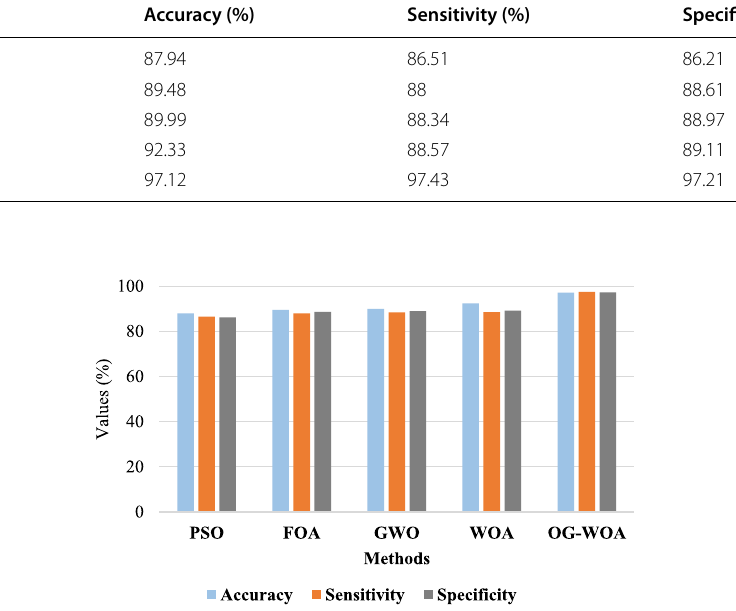
Fig. 8 Comparison of feature selection methods on AID dataset Table 2 Performance analysis of different deep learning methods for classification on AID